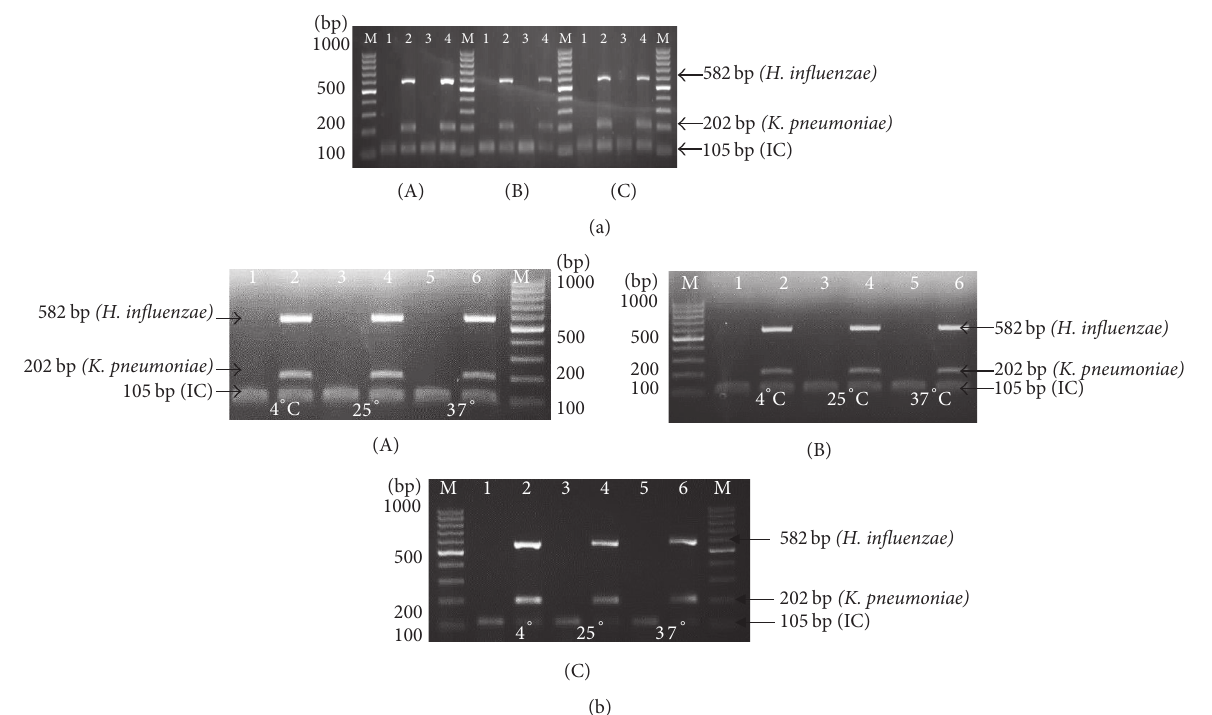
Figure 7: (a) Accelerated stability evaluation at Day 0 storage of test at different temperatures. (A) 4 ∘ C. (B) 25 ∘ C. (C) 37 ∘ C. Lane M: 100 bp DNA ladder (Fermentas, USA); Lane 1: negative control (before thermostabilization); Lane 2: positive control (before thermostabilization); Lane 3: negative control (after thermostabilization); Lane 4: positive control (after thermostabilization). (b) Accelerated stability evaluation of test at different temperatures and storage periods. (A) Day 7. (B) Day 14. (C) Day 30. Lane M: 100bp DNA ladder (Fermentas, USA); Lane 1: negative control at 4 ∘ C; Lane 2: positive control at 4 ∘ C; Lane 3: negative control at 25 ∘ C; Lane 4: positive control at 25 ∘ C; Lane 5: negative control at 37 ∘ C; Lane 6: positive control at 37 ∘